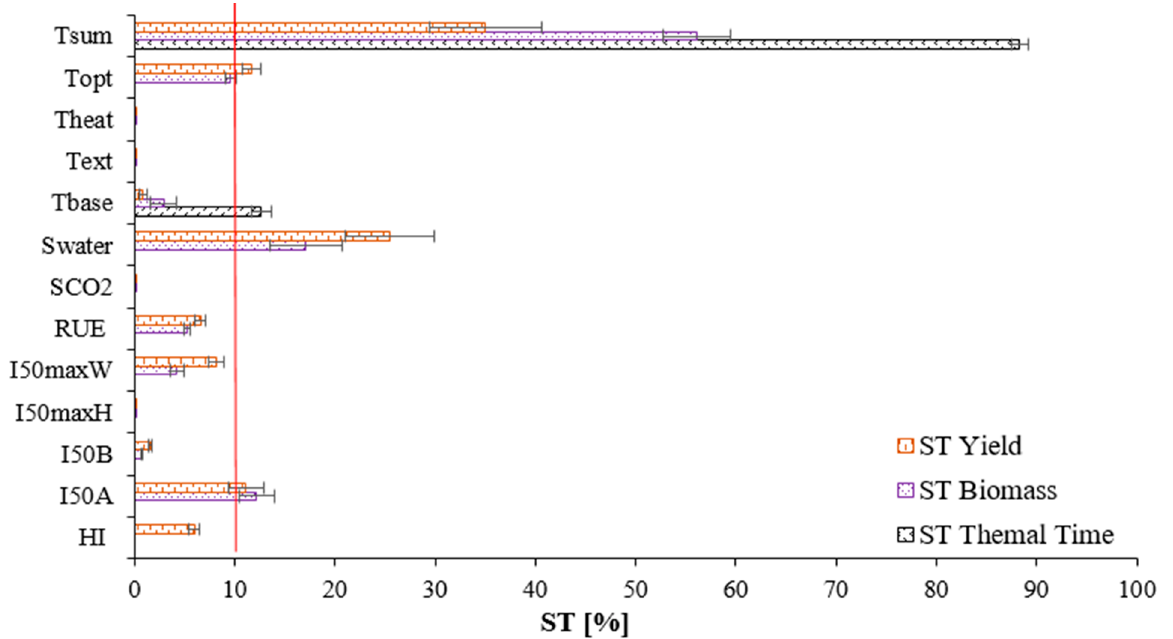
Figure 5. Total effect sensitivity indices (±standard deviation) with Sobol’s method for the irrigated bean crop for the variables predicted by the SIMPLE model; dotted line denotes a threshold of 10%.